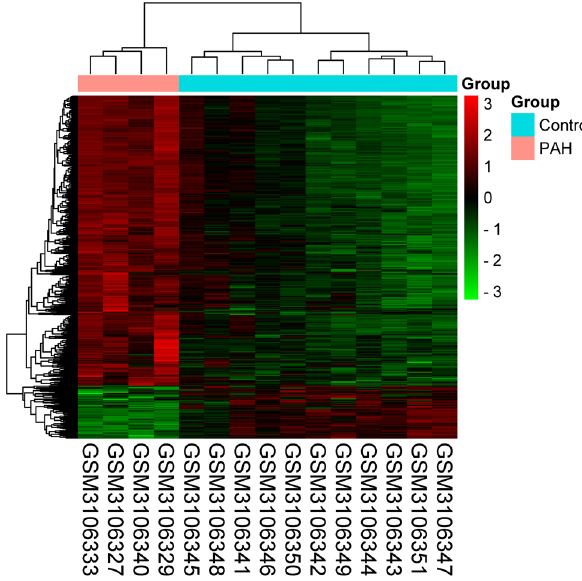
Figure 1: Clustered heatmap of DEGs in GSE113439 dataset. The green signi fi es downregulation, whereas the red represents the upregulation of